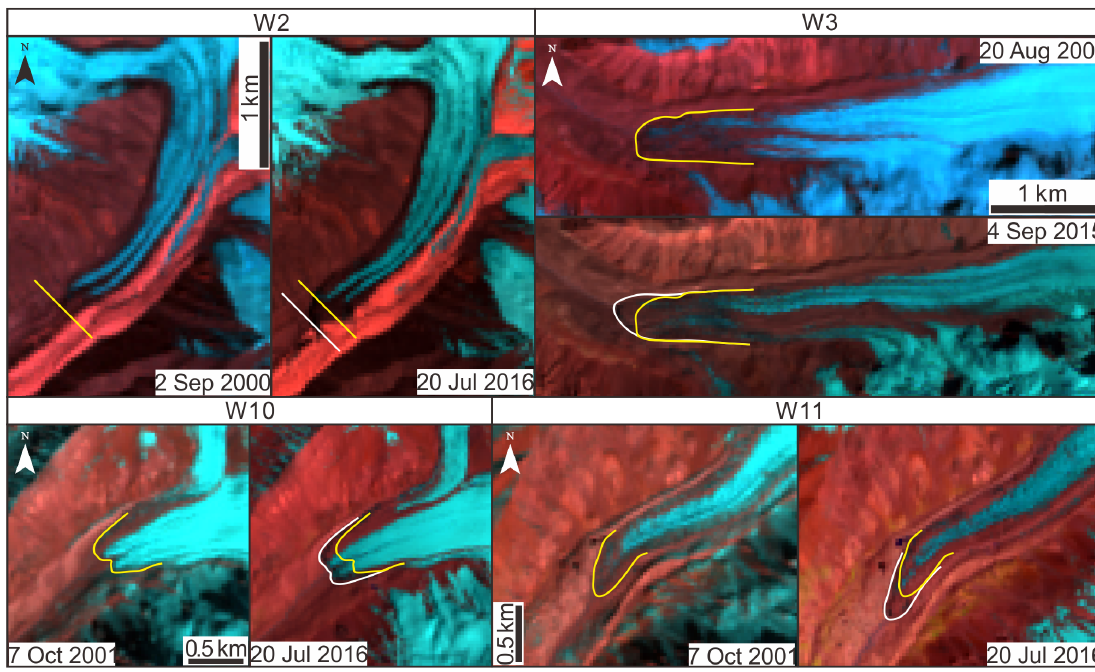
Figure 4. Comparison of the advancing glaciers before and after an advance. The yellow lines show the positions of glacier termini in early images and the white lines show the positions of the termini in recent images.